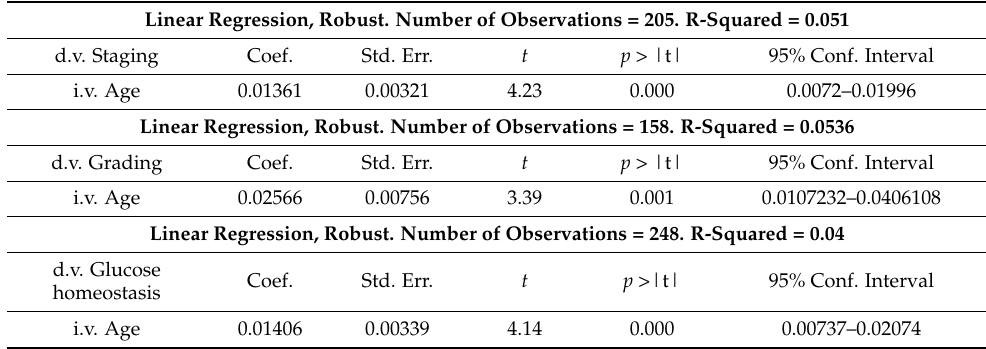
Table 3. Prediction of BCa stages and grades and glucose homeostasis by the age of patients. Linear Regression, Robust. Number of Observations = 205. R-Squared =